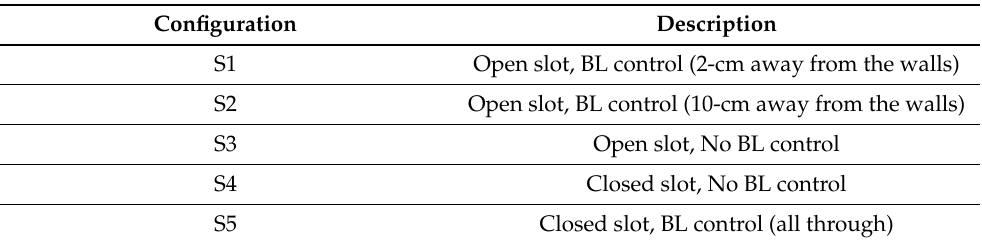
Table 1. Simulation setups. The ceiling slots are considered to be open and closed . Opening the slot prevents the formation of the BL since there is no wall. The BL control refers to tripping and BL transition, which are discussed in